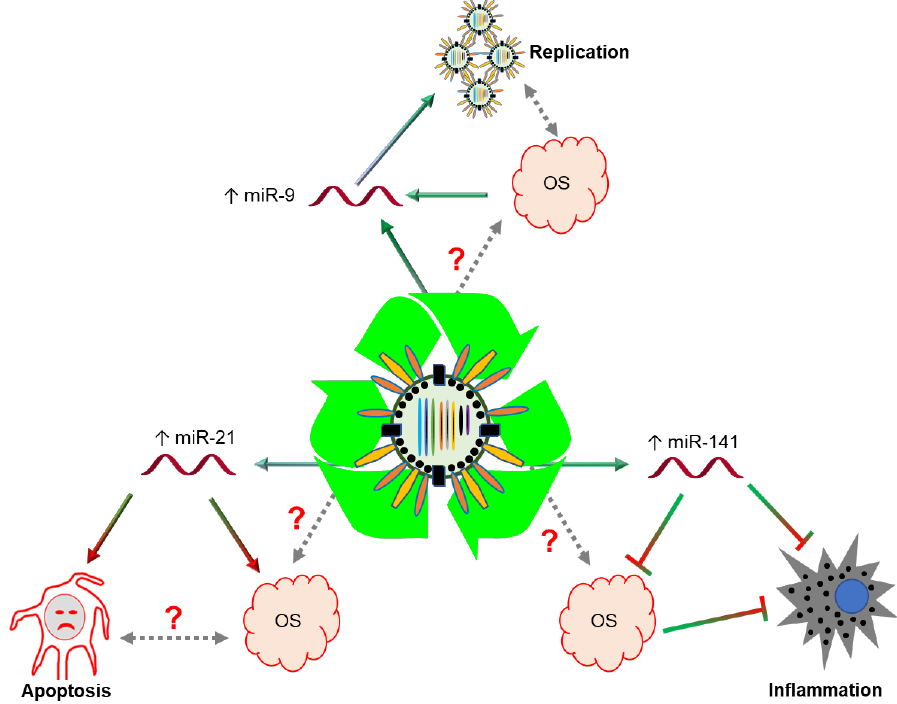
Figure 4. The different interactions among miRNA, OS, and IAV infection. Some specific miRNAs are aberrantly expressed by IAV infection and work as upstream regulators or downstream effectors in OS conditions ( → indicates activation, ⊥ indicates inhibition).